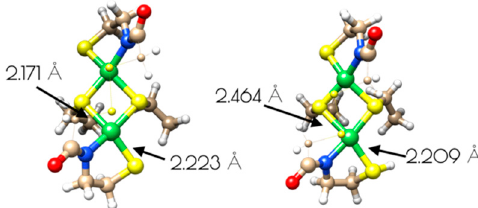
Figure 10. Structures of binuclear nickel-site models of {Ni 2II (SOD mds )} and {Ni 2II (SOD mds –S(H + )C1)}. The disulfide bridge and methylene groups have been represented as small spheres and wires for clarity.